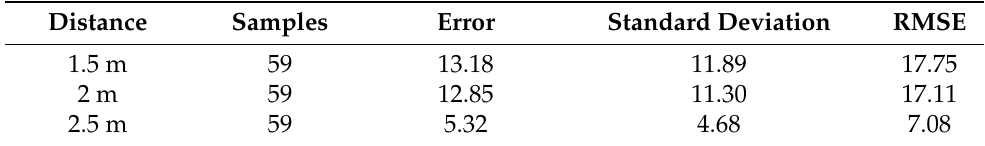
Figure 14. Linear regression of the diameter between automatic measurement and manual measure- ment at different distance (1.5 m, 2 m, 2.5 m). Table 5. Measured result after